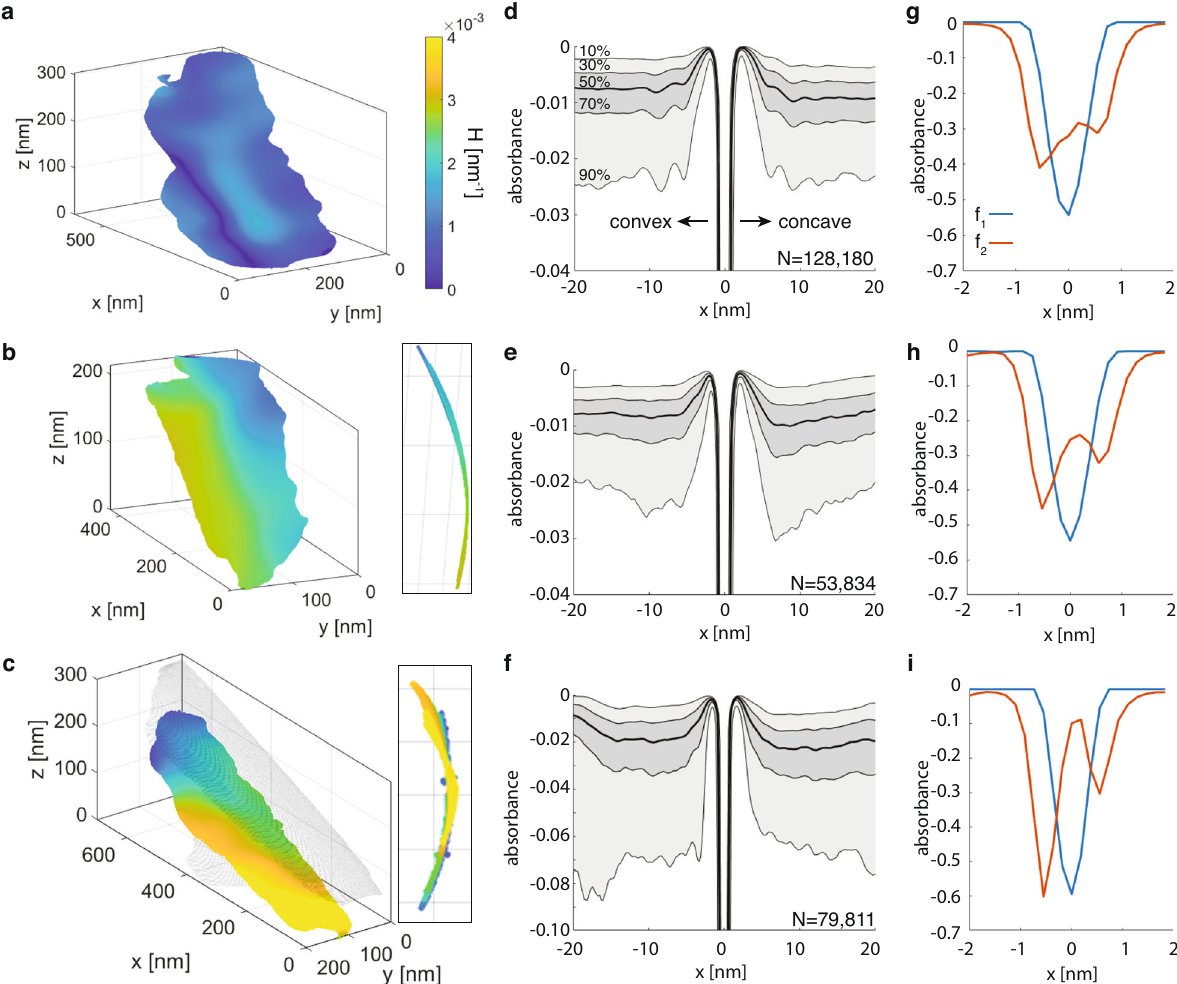
Fig. 4 Effect of layer curvature on montmorillonite-electrolyte ion-density pro fi les in 0.1 M lithium chloride. a Single exfoliated layer with low curvature. b Single layer with intermediate curvature. c Highly curved layer in an osmotic hydrate stack. Colored according to local curvature, H (Supplementary Information). d Average ion-density pro fi les from within 20 nm of convex and concave sides of the low-curvature layer. Shading indicates the percentile of observations accounted for from 128,180 individual pro fi les (i.e., ‘ 10% ’ includes the 10% lowest absorbance points at each distance). e Ion-density pro fi le from the intermediate-curvature layer. f Average ion-density pro fi les between stacked layers (note difference in scale). g Non-negative matrix factorization (NNMF) of all absorbance pro fi les in ( d ), showing fi rst two factors, f 1 (Mt) and f 2 (Li). h Increasingly asymmetric f 2 in NNMF pro fi le of curved layer in ( b ). i Highly asymmetric NNMF f 2 for curved stacked